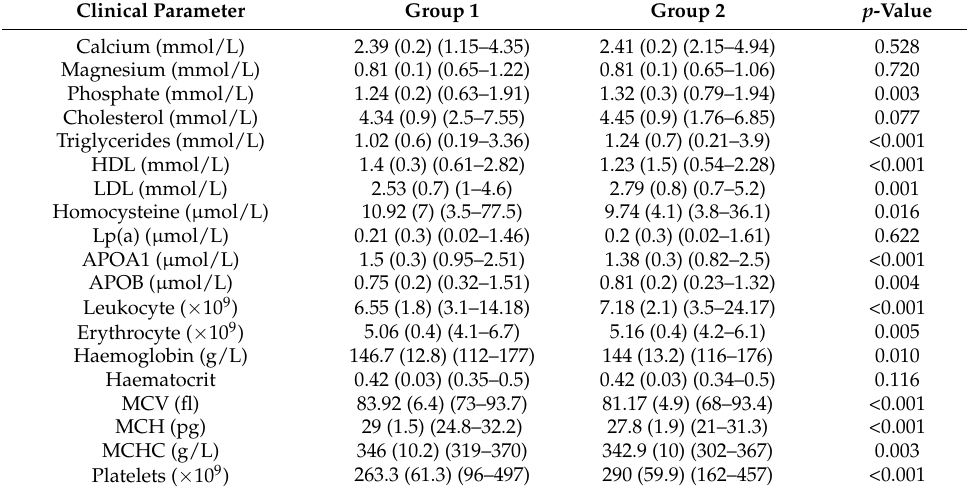
Table 3. Chi-square test for each SNP. The first Pearson chi-square value for each SNP represents the scenario when the first allele is dominant and the second when the second allele is dominant.